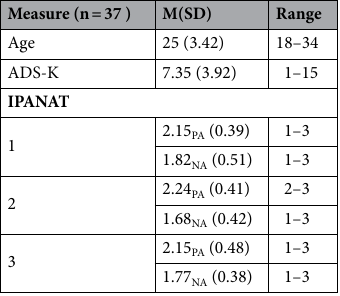
Table 1. Sample characteristics. Age in years, ADS-K, IPANAT before (1), during (2) and after (3) the emotional WM task, separately for positive affect (PA) and negative affect (NA). Additional analysis with ADS-K as well as with IPANAT is documented in supplementary